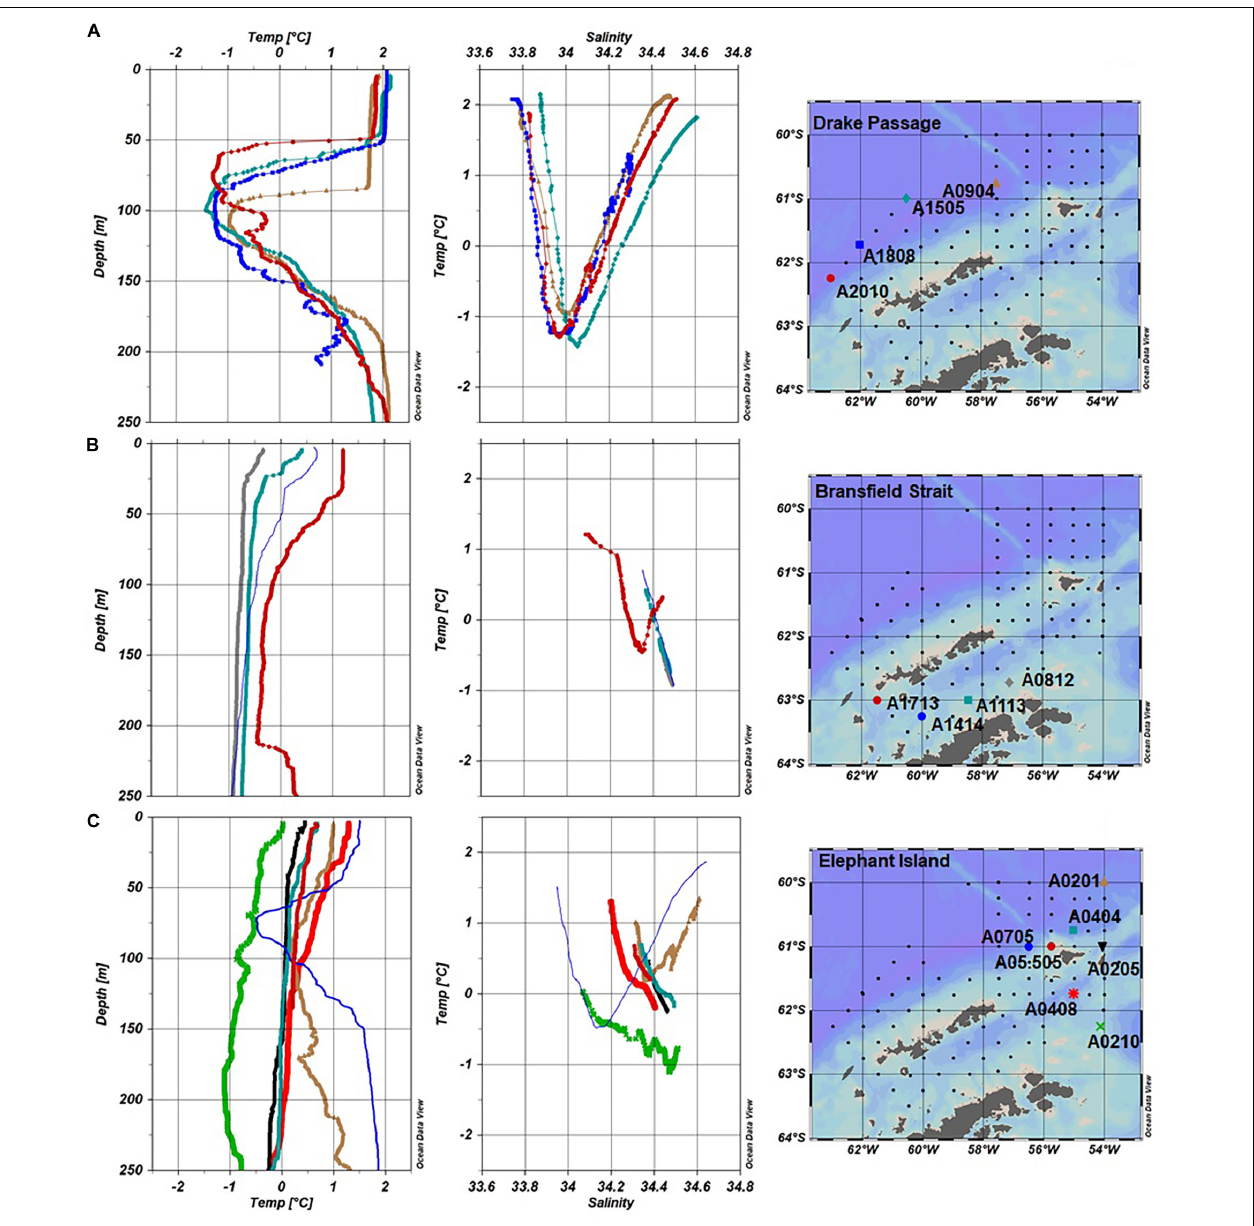
FIGURE 2 | Water type (T/S profiles) and temperature depth profiles for Fe stations in the SSI 2007 divided in groups. (A) Drake Passage (A0904, A1505, A1808, and A2010), (B) Bransfield Strait (A0812, A1113, A1414, and A17-13), and (C) Elephant Island (EIe: A0201, A0205, A0404, A0210, and A0408; EIw: A05.505